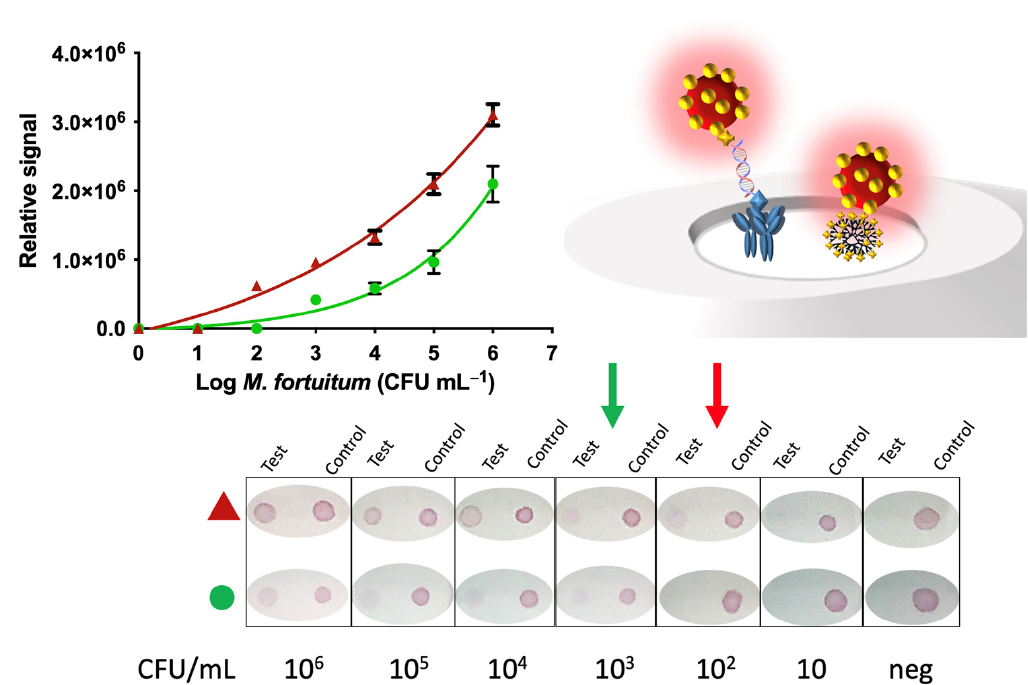
Figure 6. Results obtained for the NAVF for different CFUs mL − 1 of M. fortuitum submitted to immunomagnetic separation and preconcentration by magnetic actuation ( ▲ ) and with no magnetic preconcentration ( ● ). The negative control for the evaluation of non-specific binding is also shown.